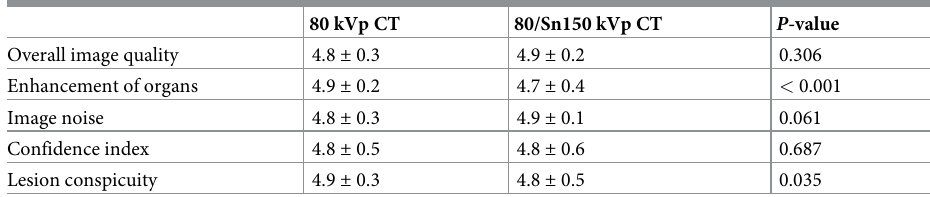
Table 5. Assessment of subjective image